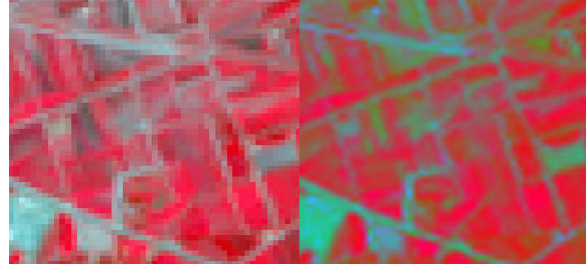
Figure 5. Original image (left) and Ehlers Fusion result (right).